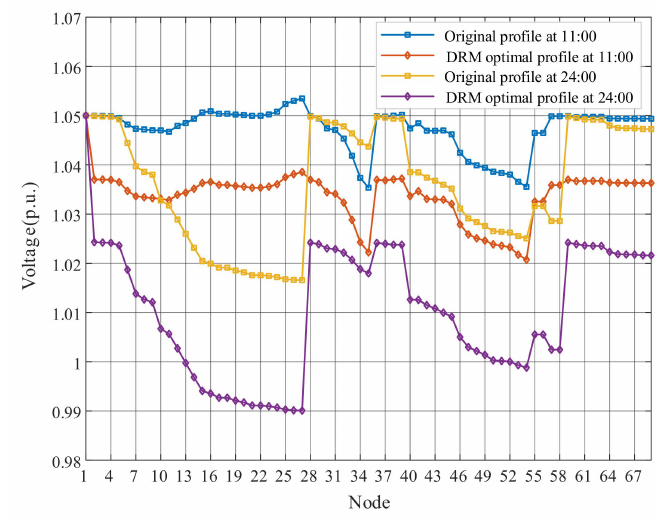
Figure 17. The nodal voltages at 11:00 and 24:00 of Case 2.